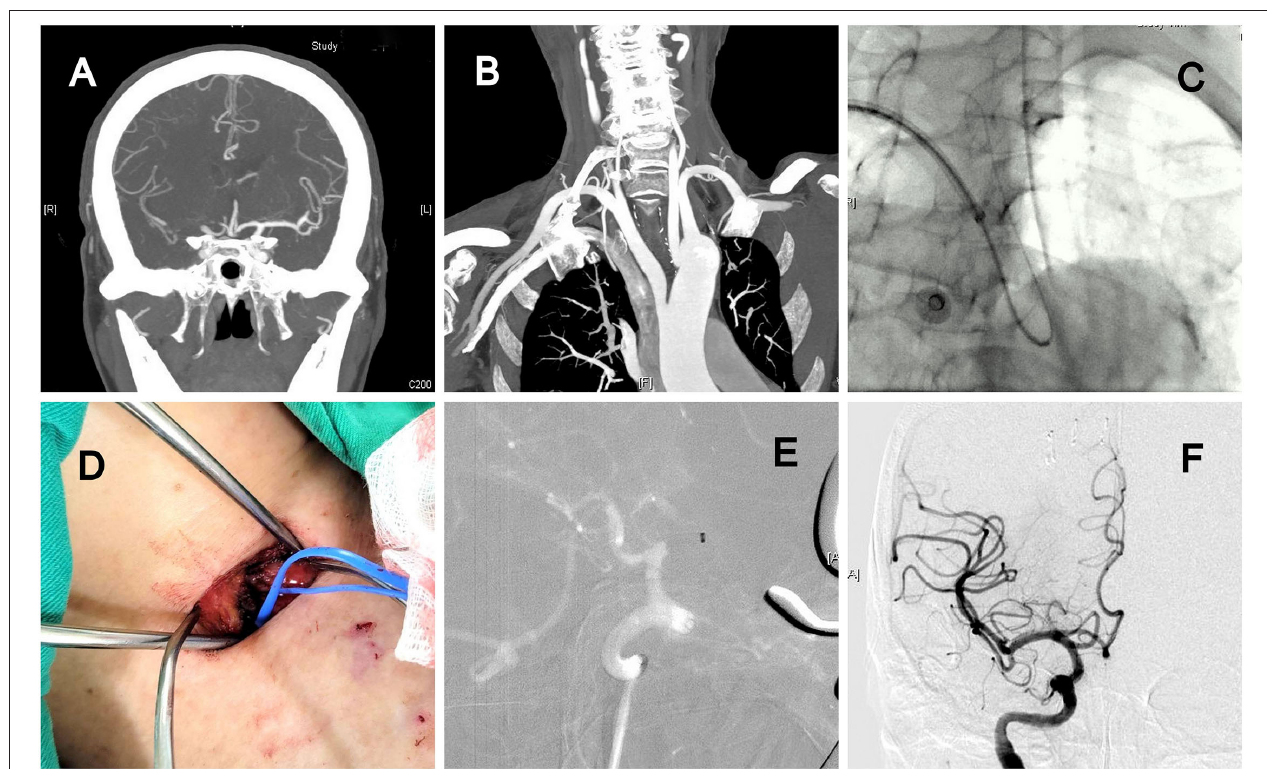
FIGURE 1 | A patient had acute right middle cerebral artery (MCA) occlusion with a type III aortic arch and sharp angle between the right subclavian artery and right common carotid artery (CCA). (A) CT angiography (CTA) indicating total occlusion of the right MCA. (B) Type III aortic arch. (C) Sharp angle, which hindered the advancement of the long sheath to the carotid artery from the right hand. (D) Carotid artery exposure through a 2-cm skin incision. (E) Direct aspiration for mechanical thrombectomy. (F) Complete recanalization of the